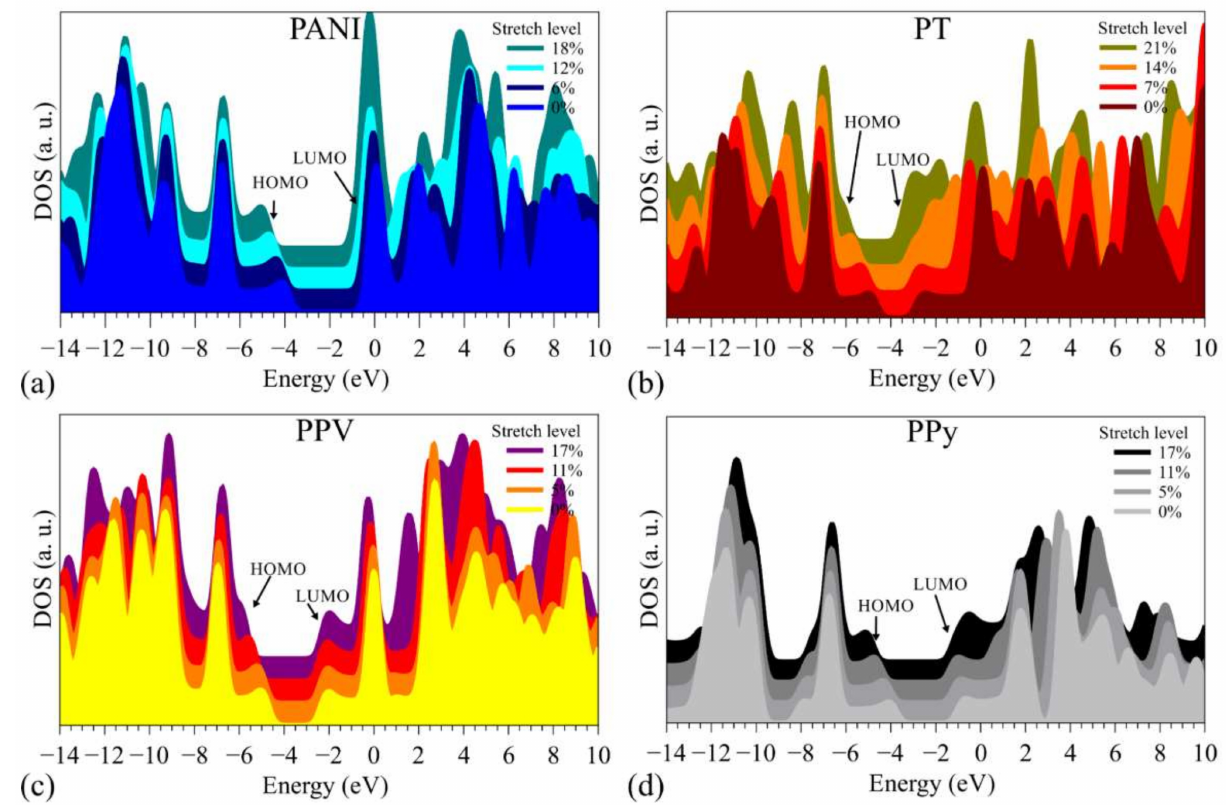
Figure 6. DOS for ( a ) PANI, ( b ) PT, ( c ) PPV, and ( d ) PPy at distinct stretch